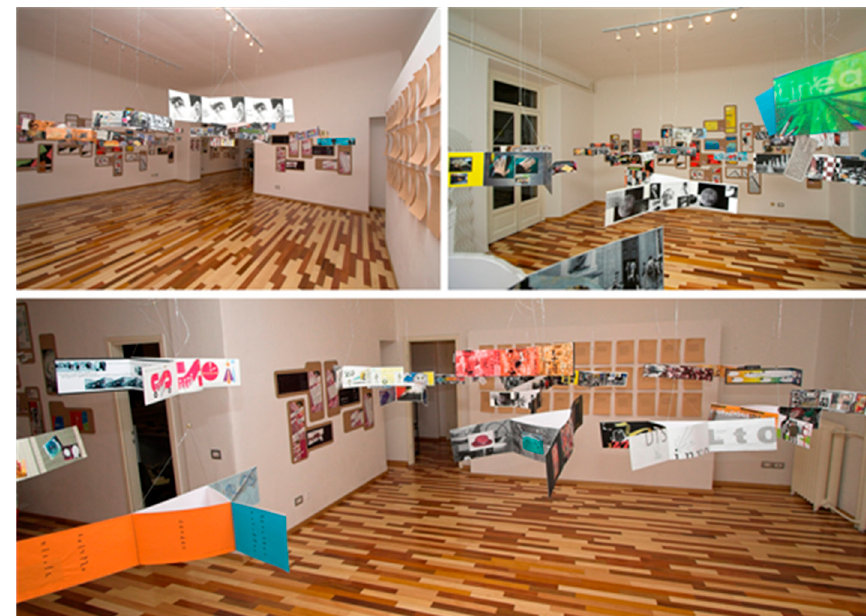
Figure 1. Images of the exhibition: “Percorsi Visivi” held in 2006 at the headquarters of AIAP Italian Association of Visual Design: visual style exercises workshop results